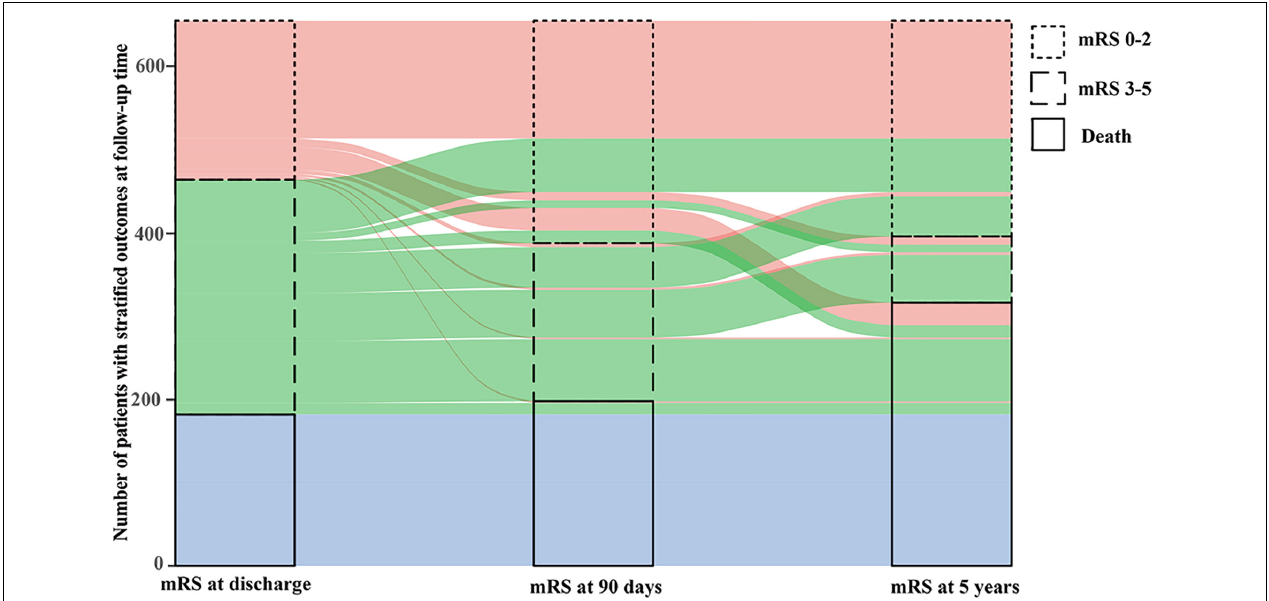
FIGURE 2 | Transformation of outcomes at different follow-up